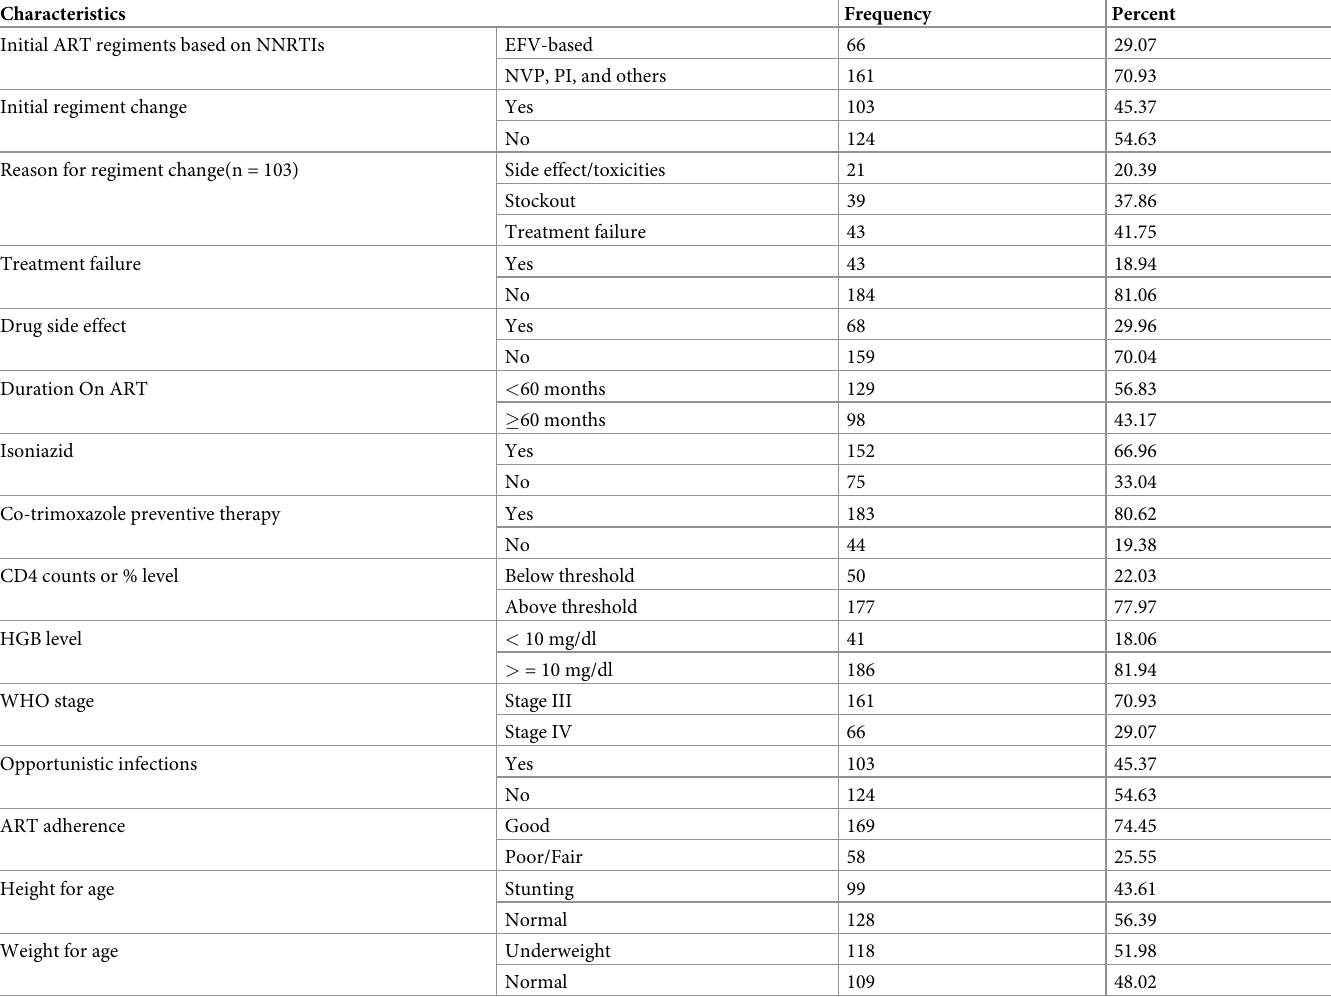
Table 2. Clinical and treatment-related characteristics among TB and HIV co-infected children after test and treat strategies launched in northwest Ethiopia hospi- tals, 2021.